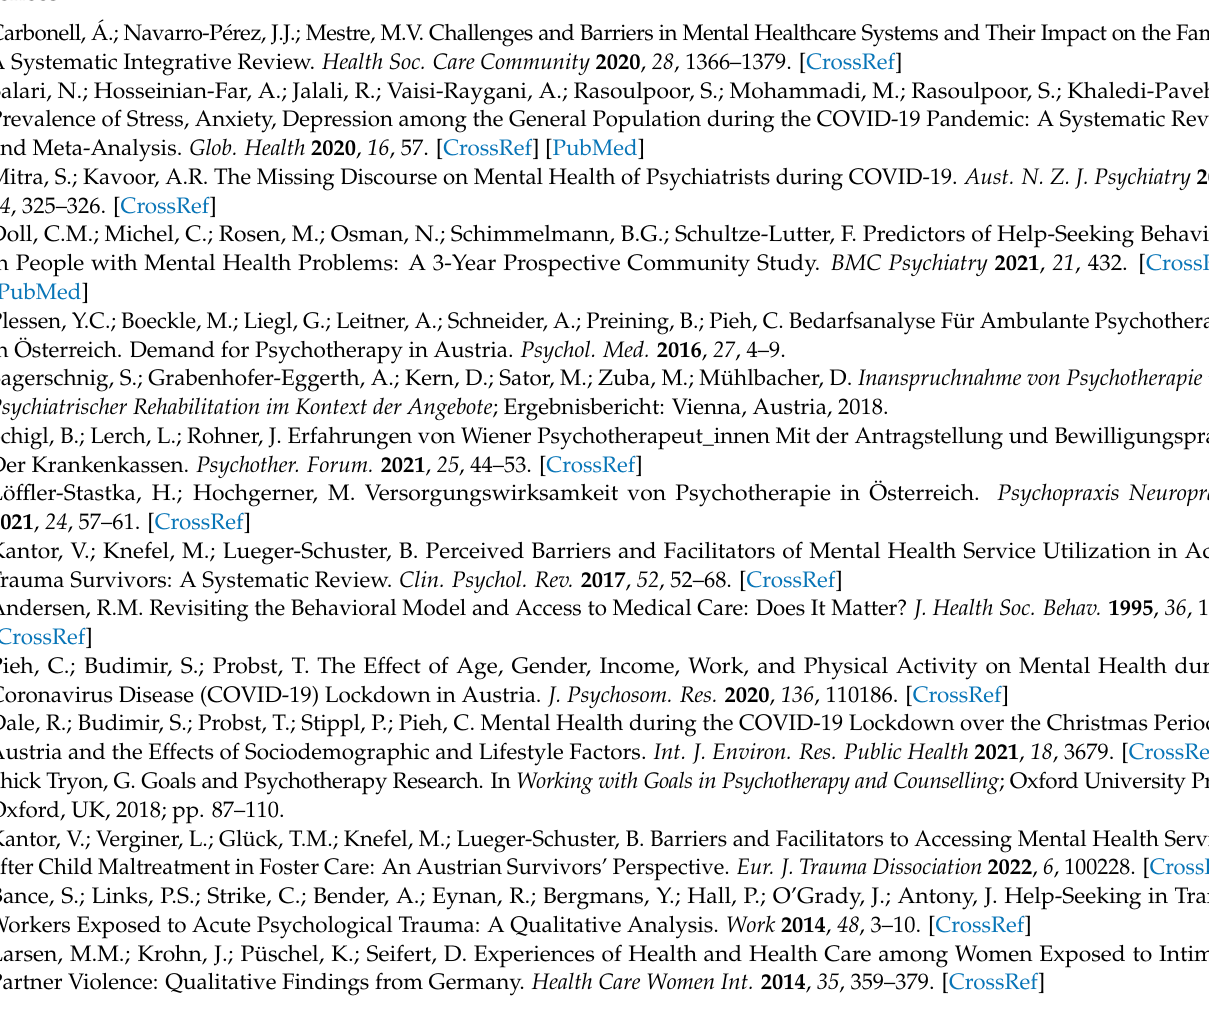
Cross-table S1.; Supplement to Section S3.2.2: Cross-tables S2 and S3, Visualisation S4 and Cross-table